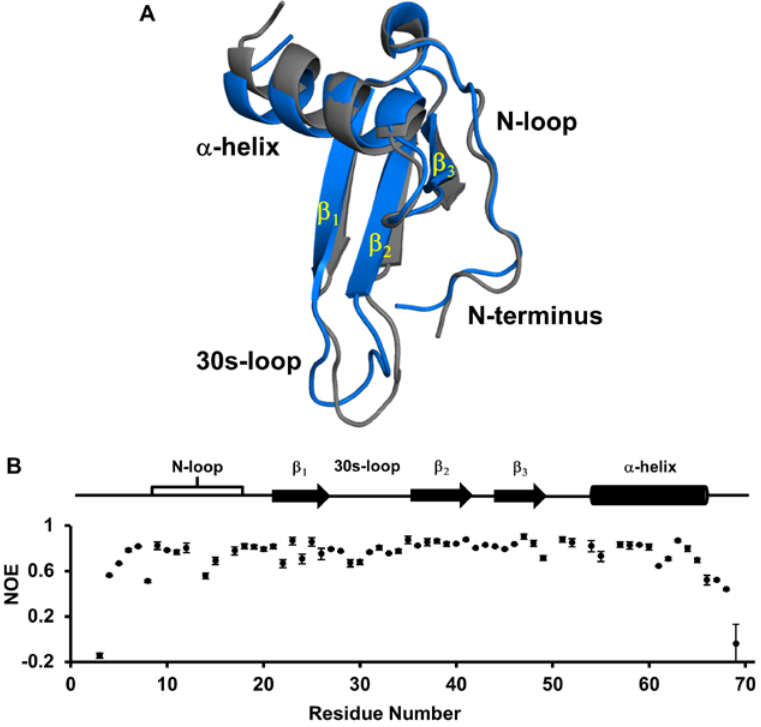
Figure 3. Structural features of the CXCL7 monomer. ( A ) Ribbon diagram of the CS-based CXCL7 monomer (blue) overlaid on a monomer of the tetramer (gray). Major structural regions are labeled; ( B ) Heteronuclear NOE data of the native CXCL7 monomer are shown. Secondary structural elements are given for reference.